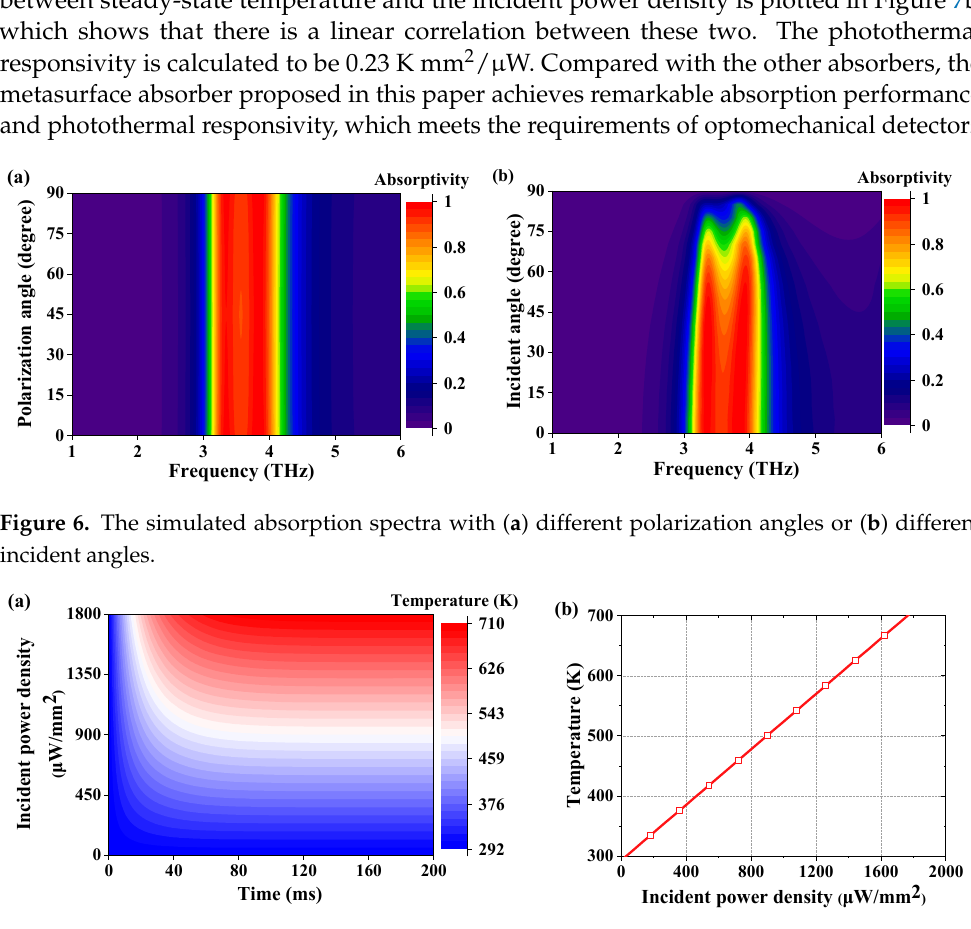
Figure 7. ( a ) The process of rising temperature. ( b ) The simulated photothermal responsivity of metasurface absorber.